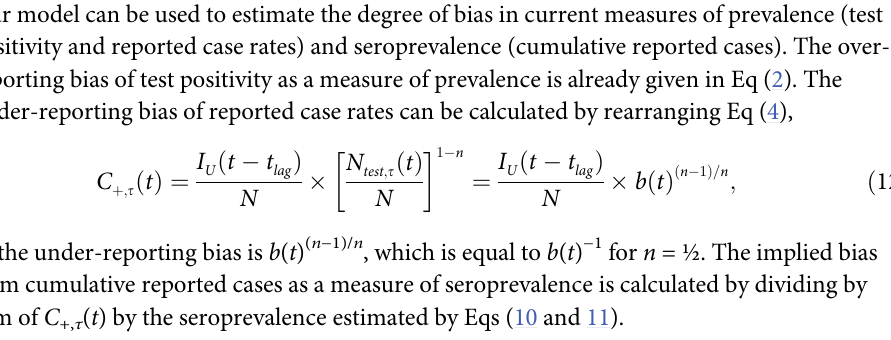
Table B. State-wide seroprevalence validation data. Table C. Posterior distributions and con- vergence diagnostic of n and SP for individual states (random effects). Table D. Primary o model posterior estimates of prevalence (undiagnosed and total) and seroprevalence as of December 31, 2020. Table E. Geometric mean model posterior estimates of prevalence (undi- prevalence data. Fig A. Posterior distributions of the power parameter n and the seroprevalence offset SP for individual states using the primary random effects model. o